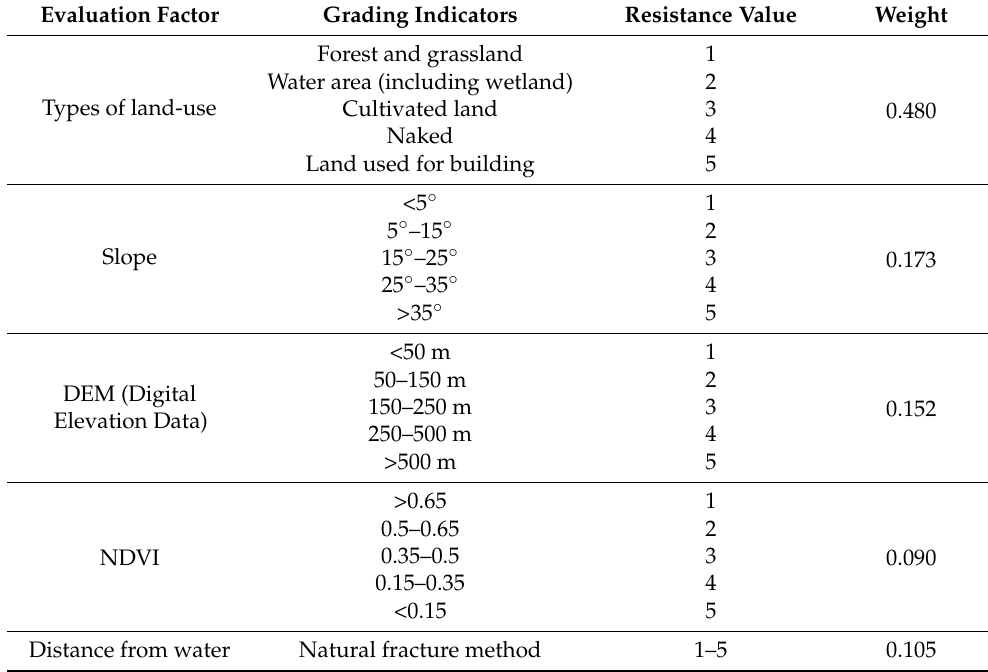
Table 3. Resistance factors and associated